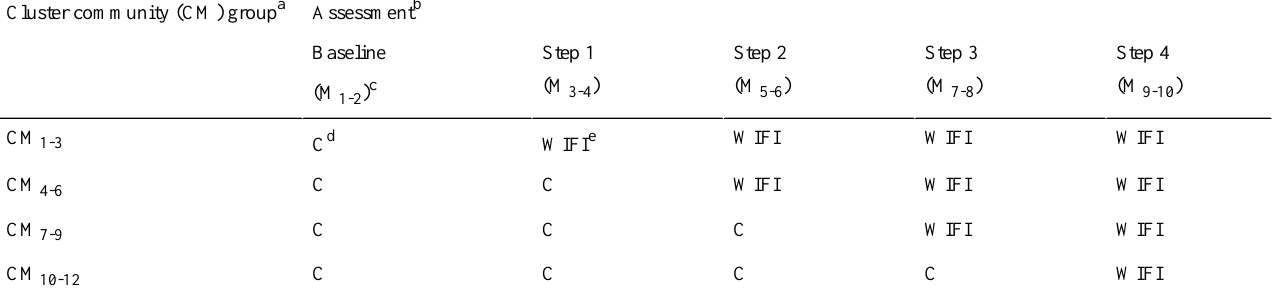
Table 1. Design of the four-stage stepped-wedge cluster randomized